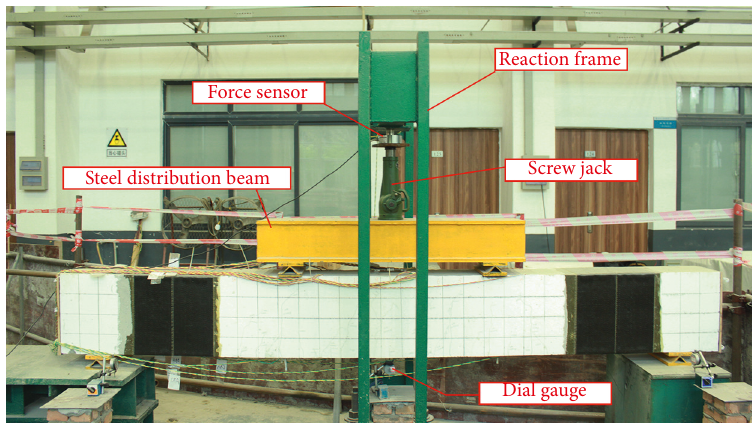
Figure 2: Experiment setup in laboratory.